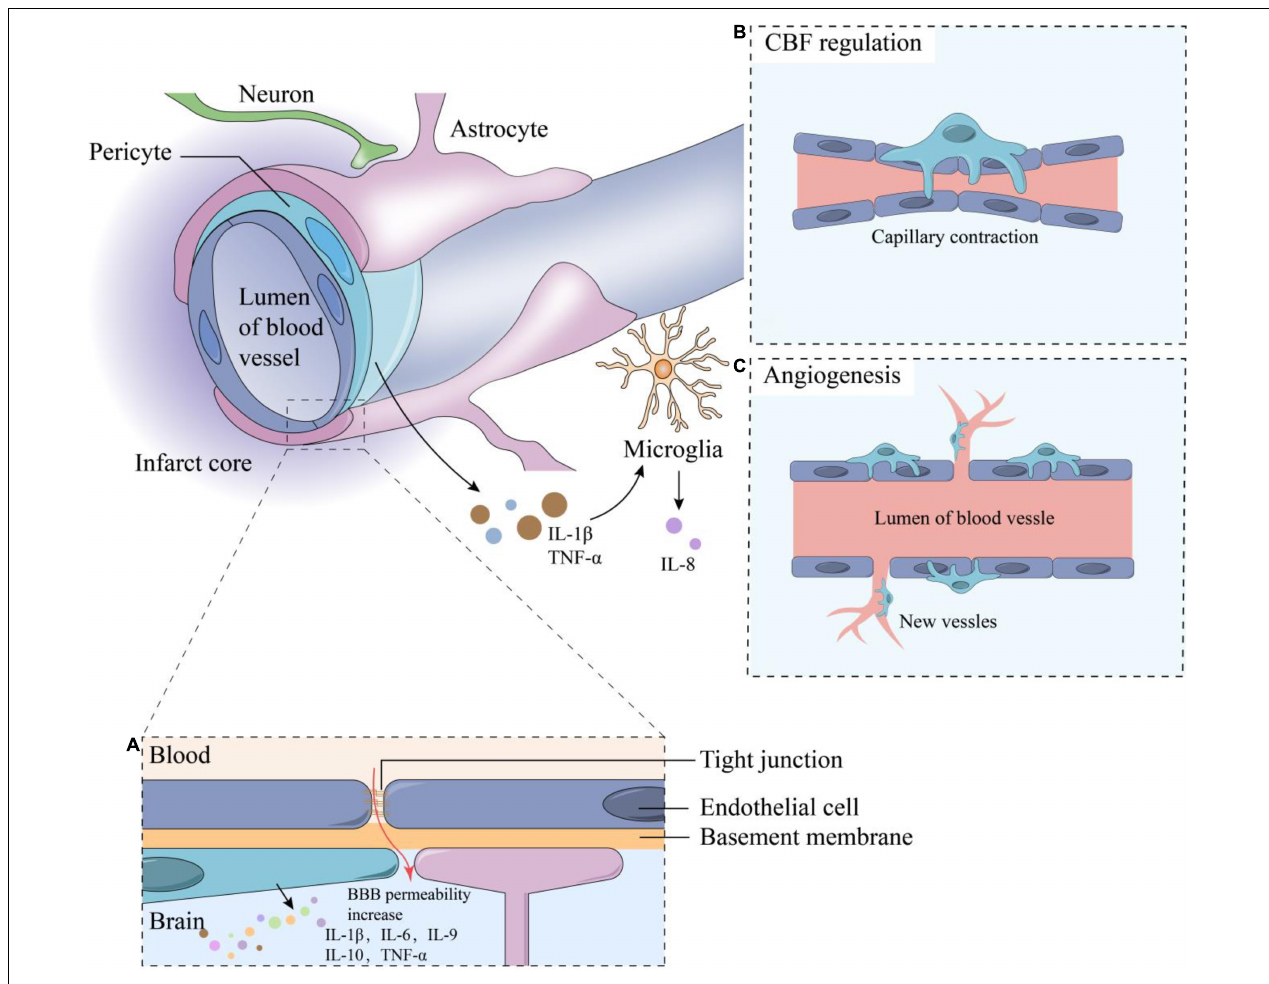
FIGURE 1 | The composition of neurovascular units and functions of pericytes. The components of NVU including neurons, astrocytes, microglia, vascular endothelial cells, pericytes, basement membrane and extracellular matrix, and adjacent endothelial cells are connected by tight junctions. Some functions of pericytes including: (A) Inflammation response: when IS occurs, the BBB permeability increase, stimulating the inflammatory responses and cytokine secretion of pericytes such as IL-1 β , IL-6, IL-9, IL-10, etc.; (B) CBF regulation; (C) Angiogenesis. TNF- α and IL-1 β secreted by pericytes can stimulate microglia to secrete IL-8. CBF, cerebral blood flow; BBB, blood-brain barrier; TNF, tumor necrosis factor; IL,